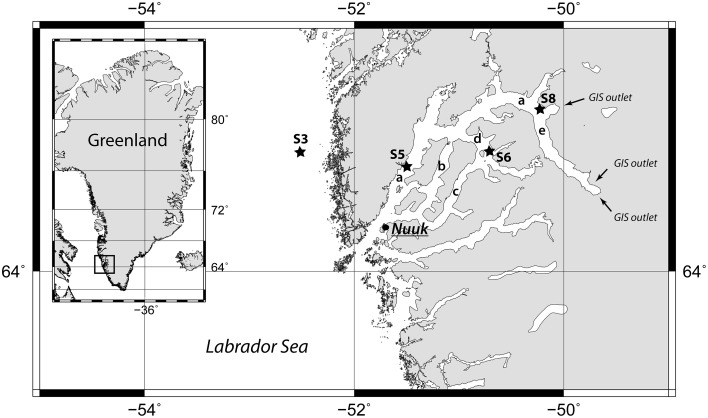
Map of the Godthåbsfjord region including the four coring stations marked with black stars. The arrows indicate the three outlets of the Greenland Ice Sheet (GIS) to the Kangersuneq. The letters indicate, a, main fjord (Nûp Kangerdlua); b, Qôrnup Suvdlua; c, Ũmánap Suvdlua; d, Kapisigdlit Kanderdluat; e, Kangersuneq. Map created with GMT5 (http://gmt.soest.hawaii.edu/).